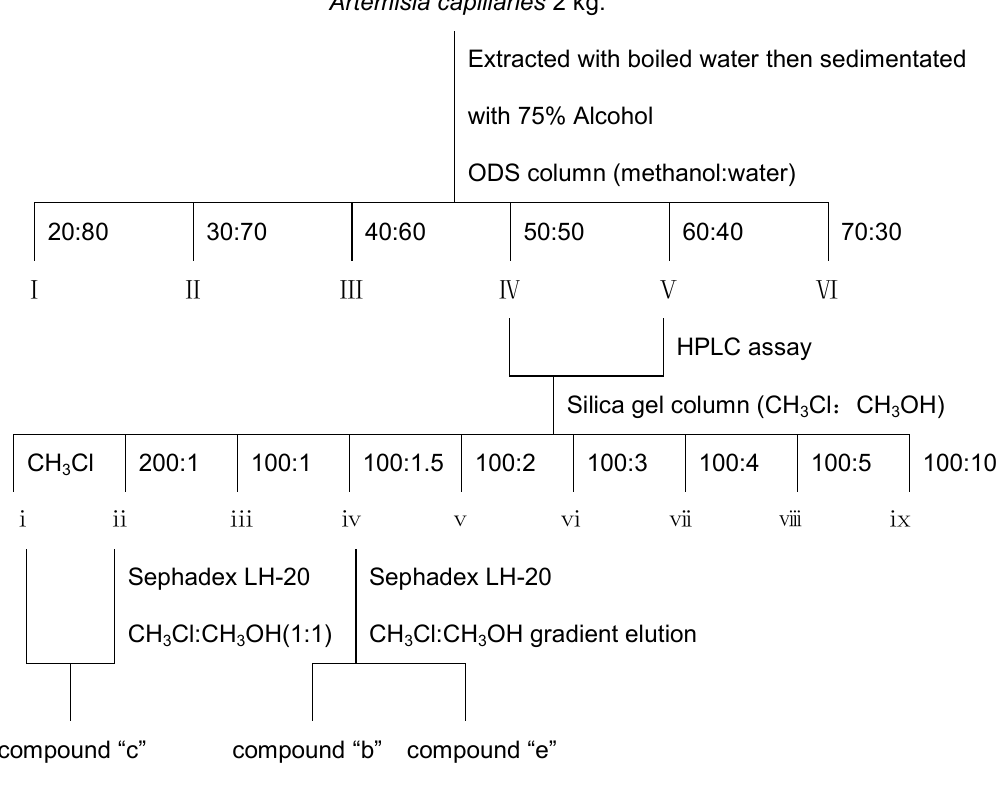
Figure 4. Extraction and purification of compounds extracted by HE-HPLC. Artemisia capillaries 2